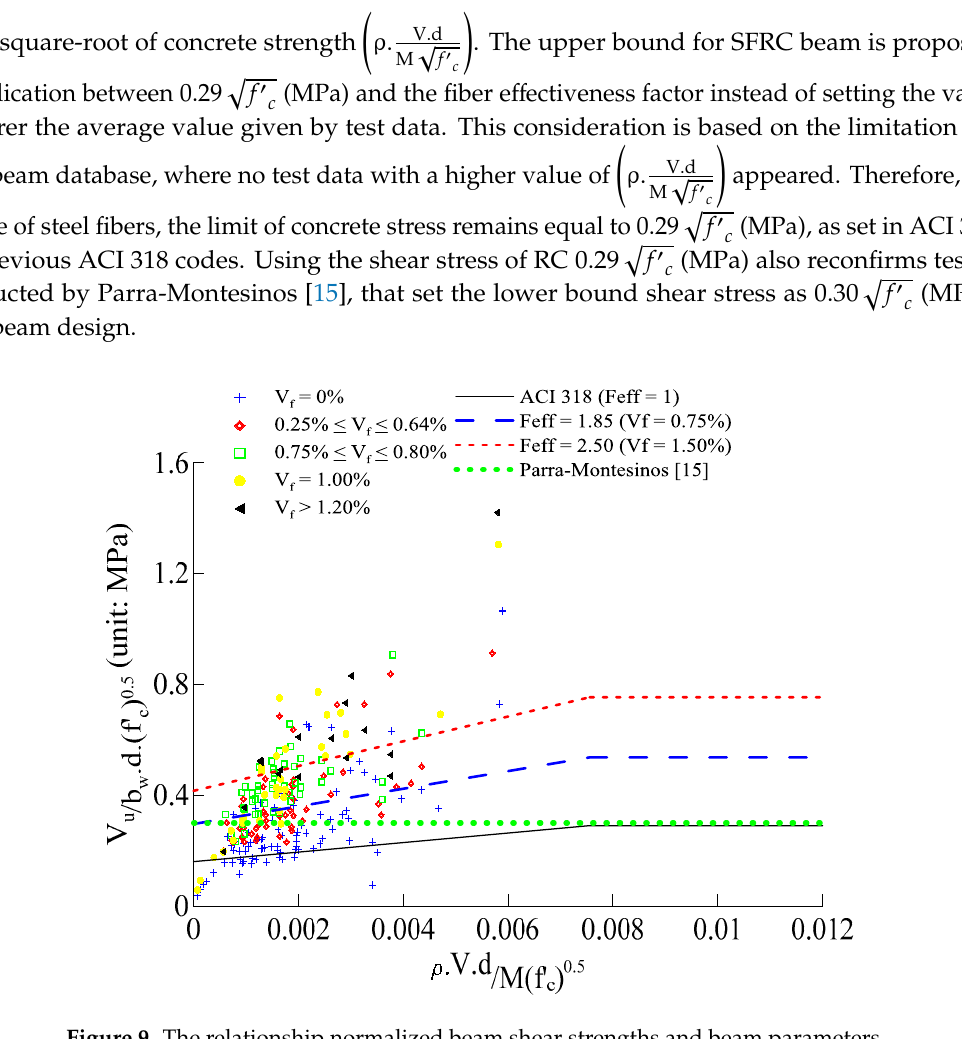
Figure 9. The relationship normalized beam shear strengths and beam parameters.